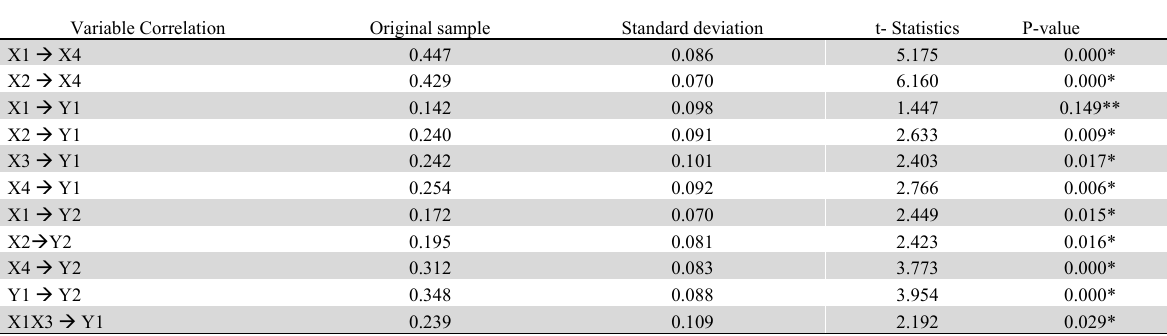
Path Coefficient or Variable Direct